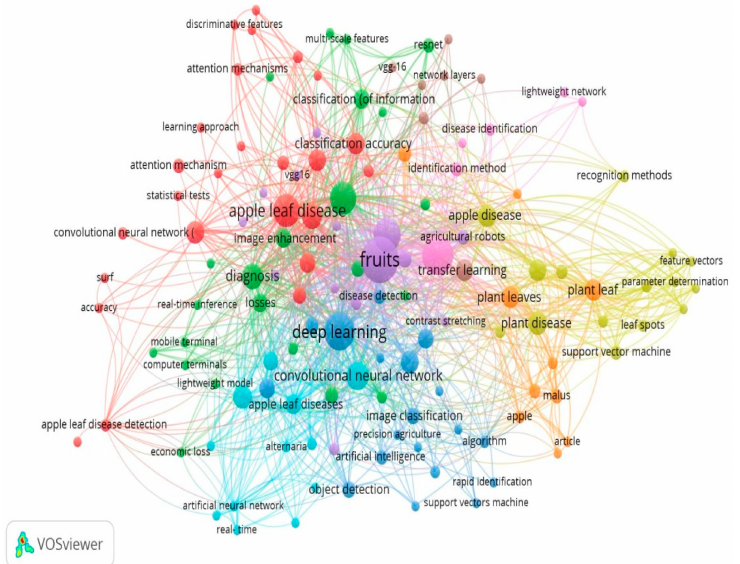
Figure 22. Structure of Keyword Wise Co-occurrence Network (Source: https://www.vosviewer.com (accessed on 14 September